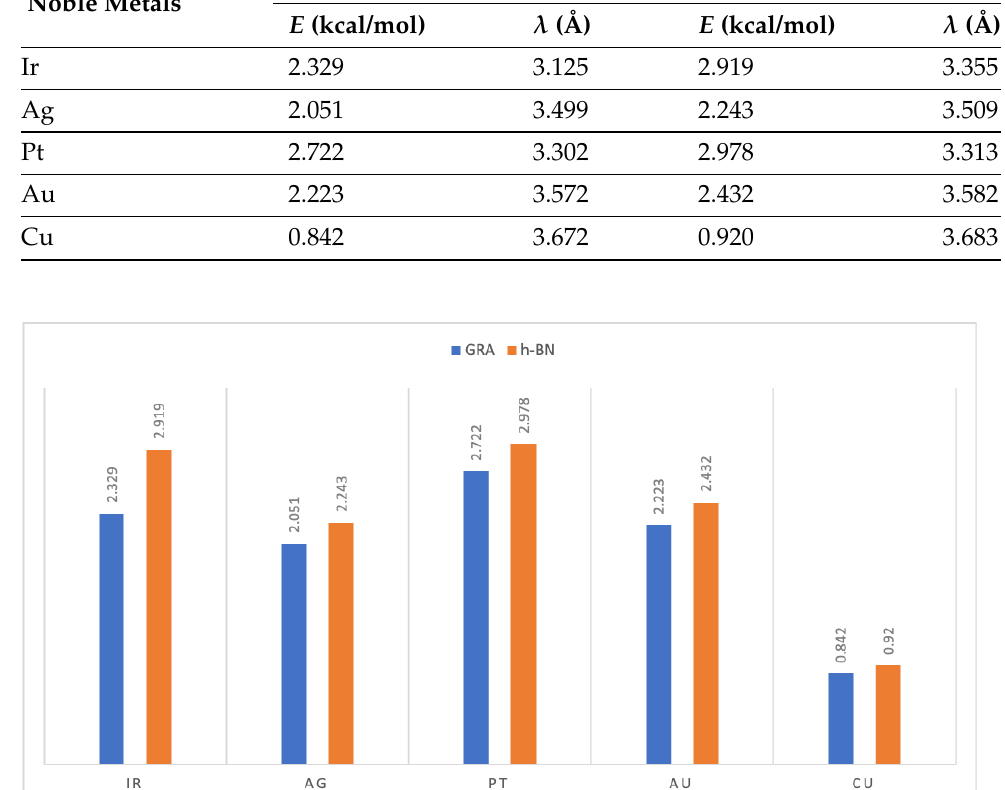
Figure 4. Comparison of the binding energies E (kcal/mol) of noble metal atoms on GRA and